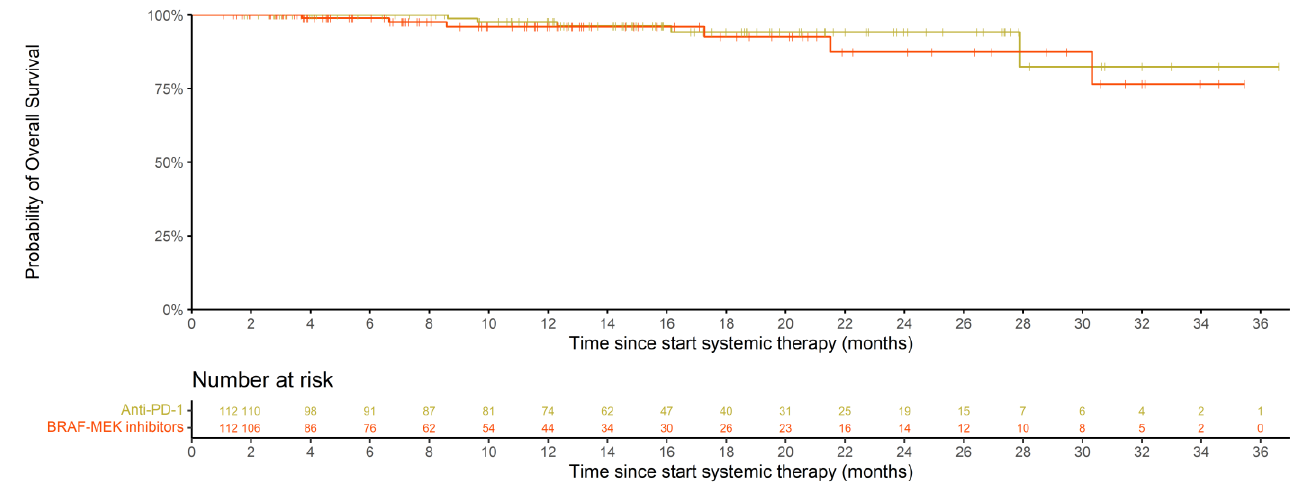
Figure 4. Overall survival (OS) of BRAF/MEK- and anti-PD-1-treated patients after nearest neighbor propensity score matching.